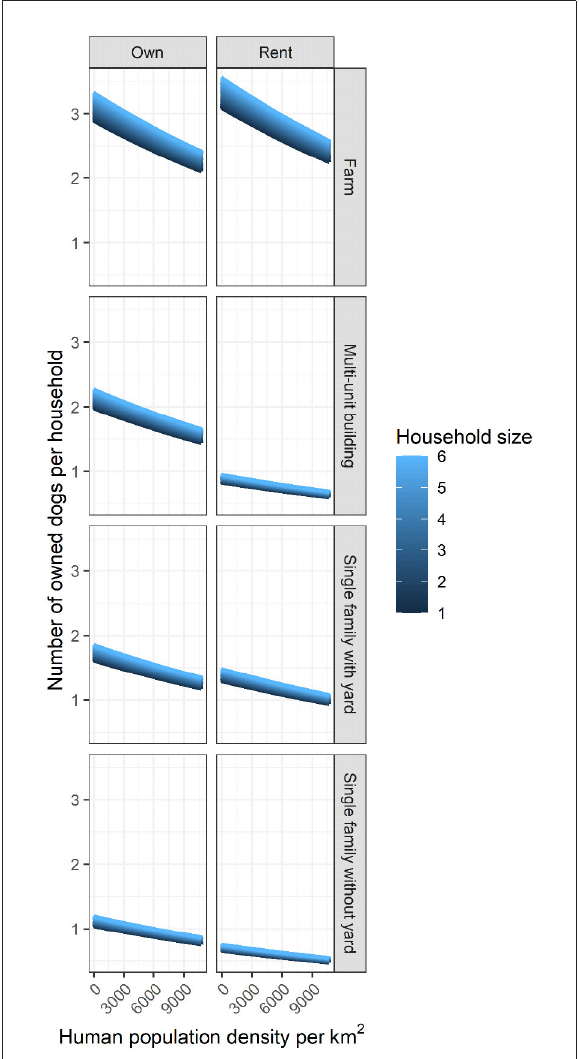
FIGURE4 Mean predicted number of owned dogs by population density, household size, dwelling ownership type, and ownership status among residents of Costa Rica. All predictions are standardized to the mean elevation of 961m for all